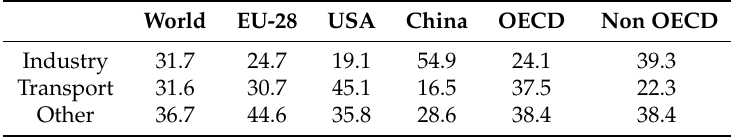
Figure 2. ( a ) Energy consumption (in billion toe) by the end user. ( b ) Compound annual growth rate (data from [28]). Table 2. Energy consumption share (%) by the end user in different regions in 2016.